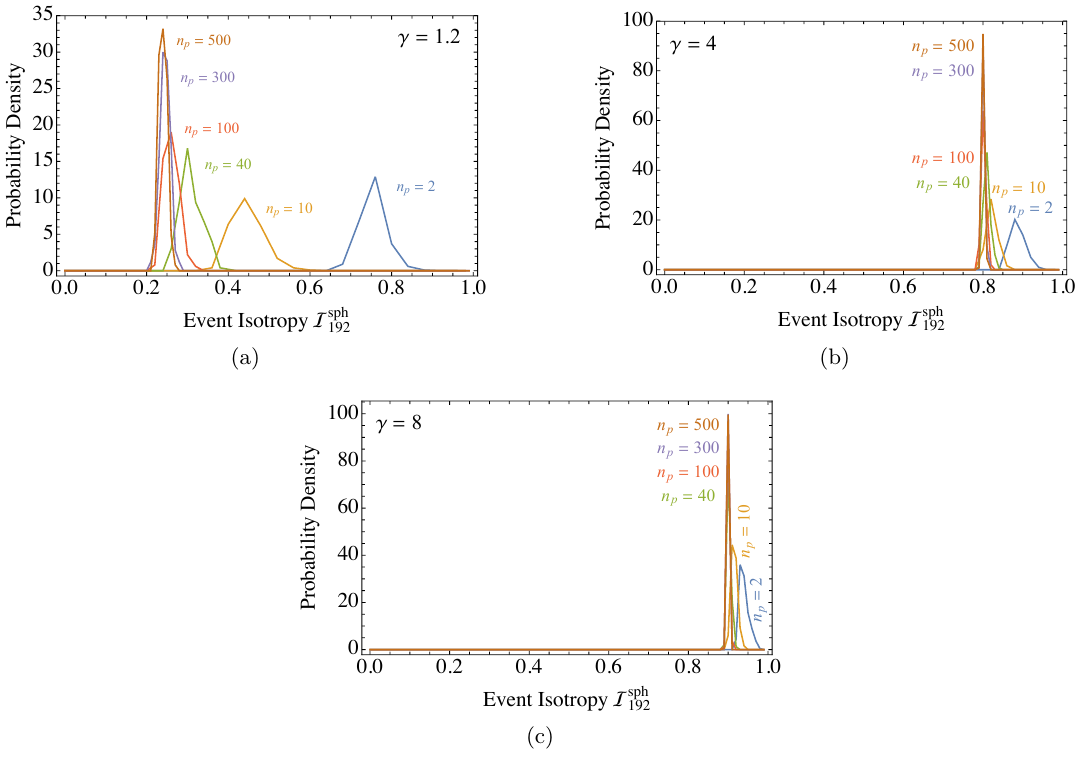
of the boosted toy model for n = 2, 10, 40, p 192 ∼ 1 ) and overlap substantially. 192 + ν is a positive even integer, then there is − ν 2 3 1